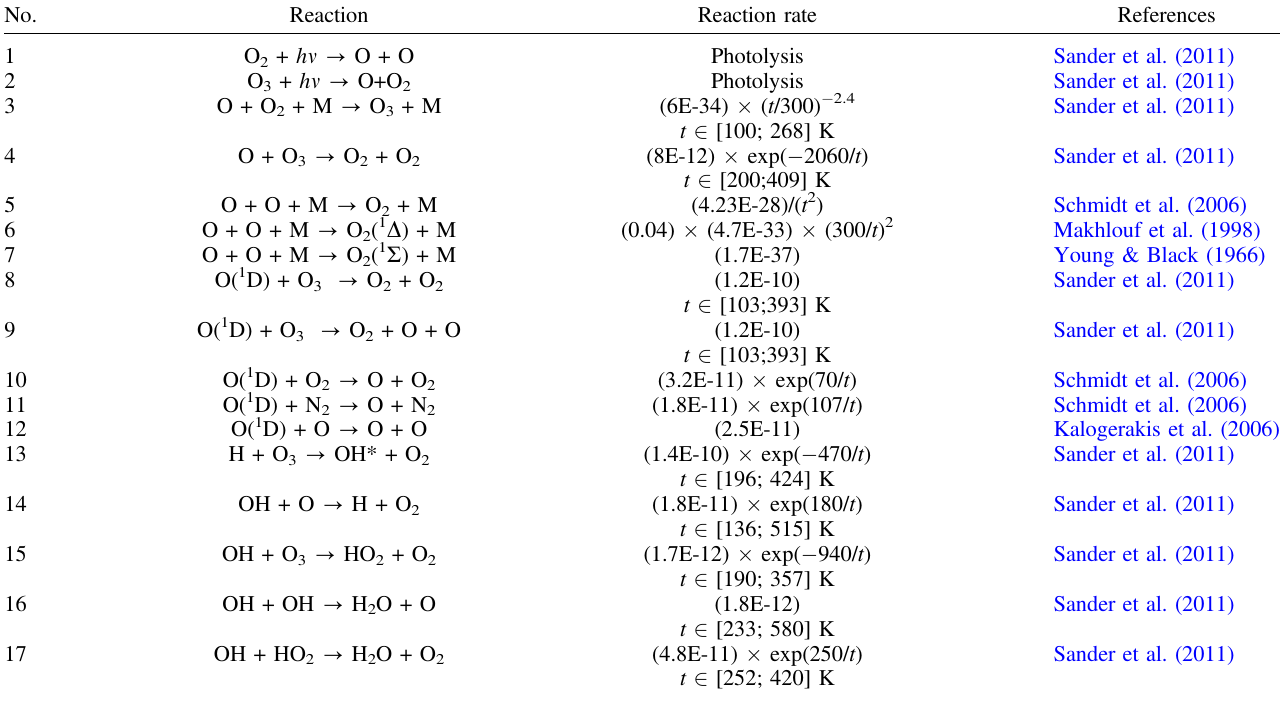
Table A.1. List of the reactions used in the model. Most of the references of the reaction coef fi cients are taken from Sander et al. (2011). No. Reaction Reaction